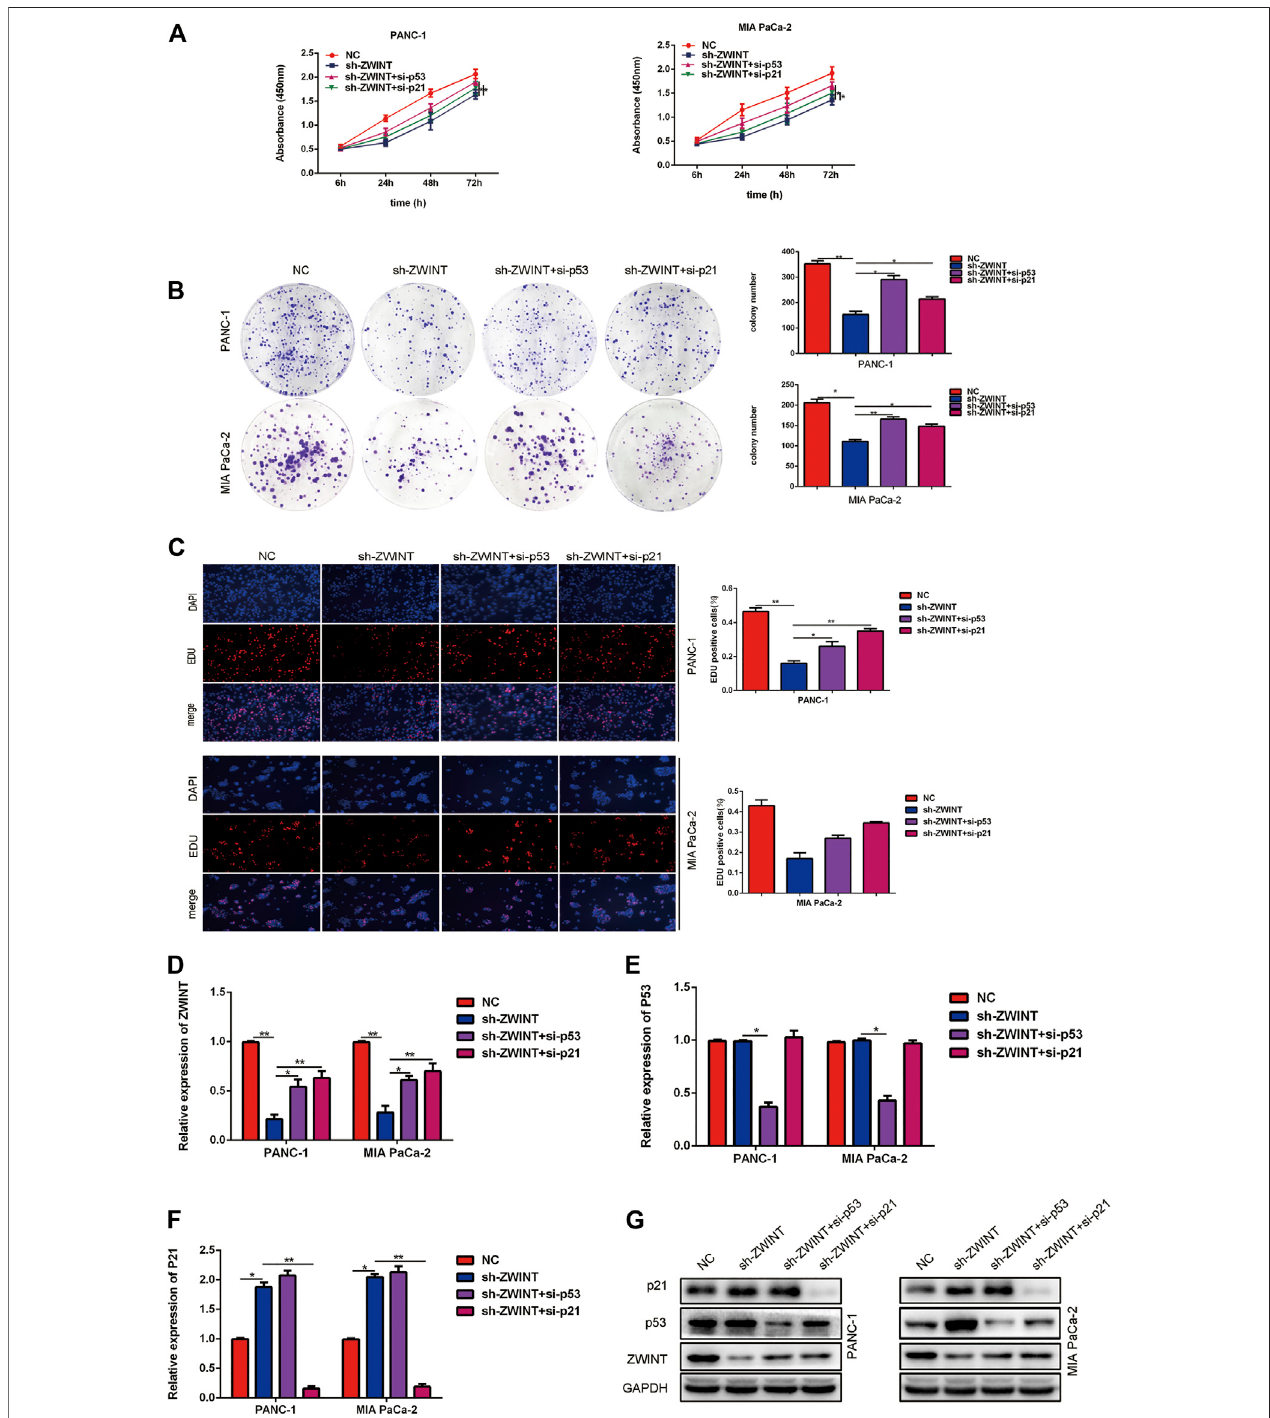
FIGURE 6 | ZWINT exerted proliferation effects by directly promoting the transcription of p21. CCK-8 (A) , plate formation (B) and EDU (C) and assay analysis the proliferation of the cells in the ZWINT knockdown transfected with p53 or p21 siRNA. (D – G) qRT-PCR and western blot assays analysis the ZWINT, p53 and p21 expression of the cells in the ZWINT knockdown transfected with p53 or p21 siRNA.